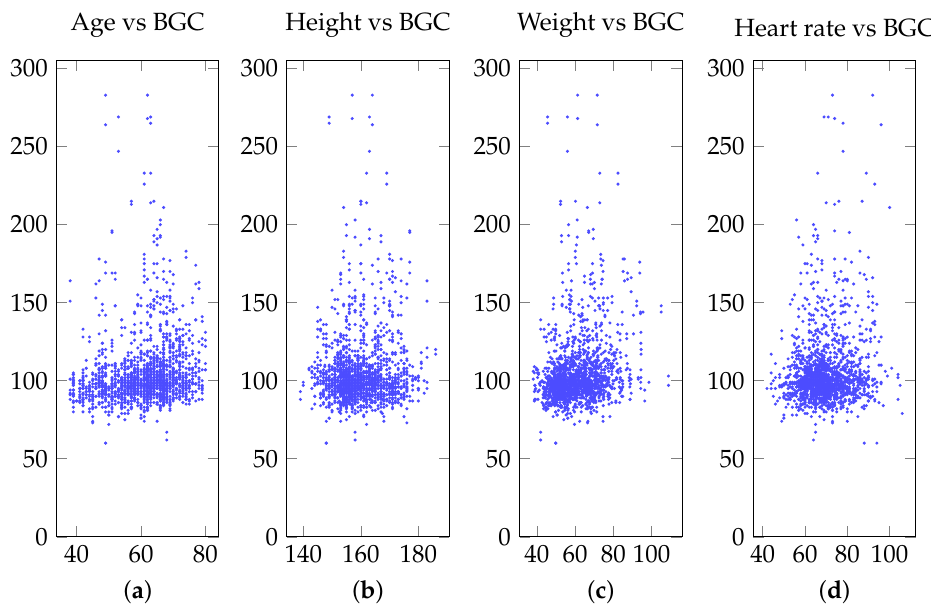
Figure 4. Distribution of the blood glucose concentration (BGC) with different profile information: